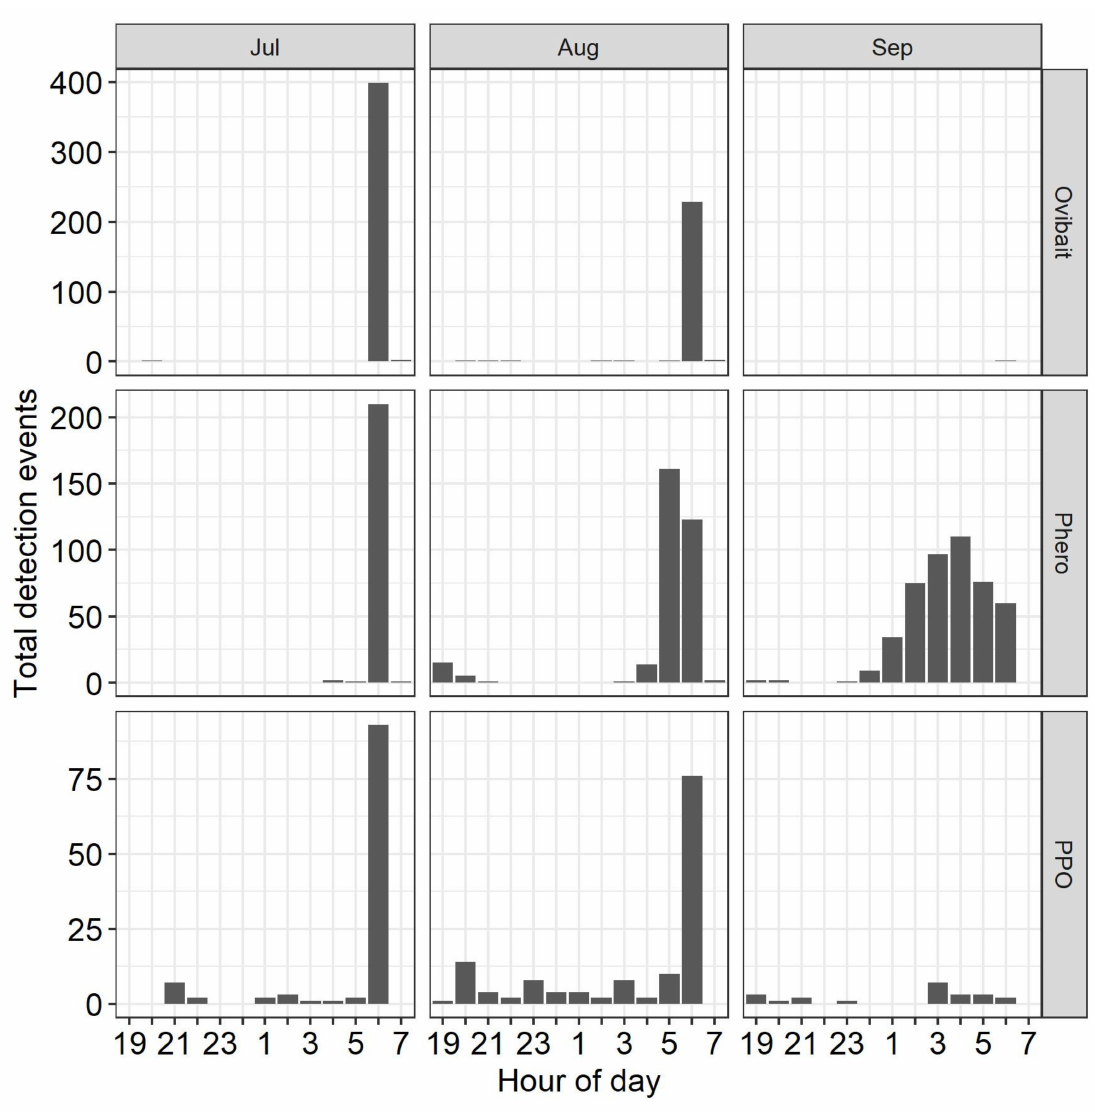
Figure 5. Seasonal phenology of navel orangeworm captured in conventional sticky wing traps or detected with a FarmSense pseudoacoustic sensor with either a female ovipostional bait, a pheromone monitoring lure, or a phenyl propionate (PPO) dispenser as an attractant. Points and error bars represent mean and standard error (n =